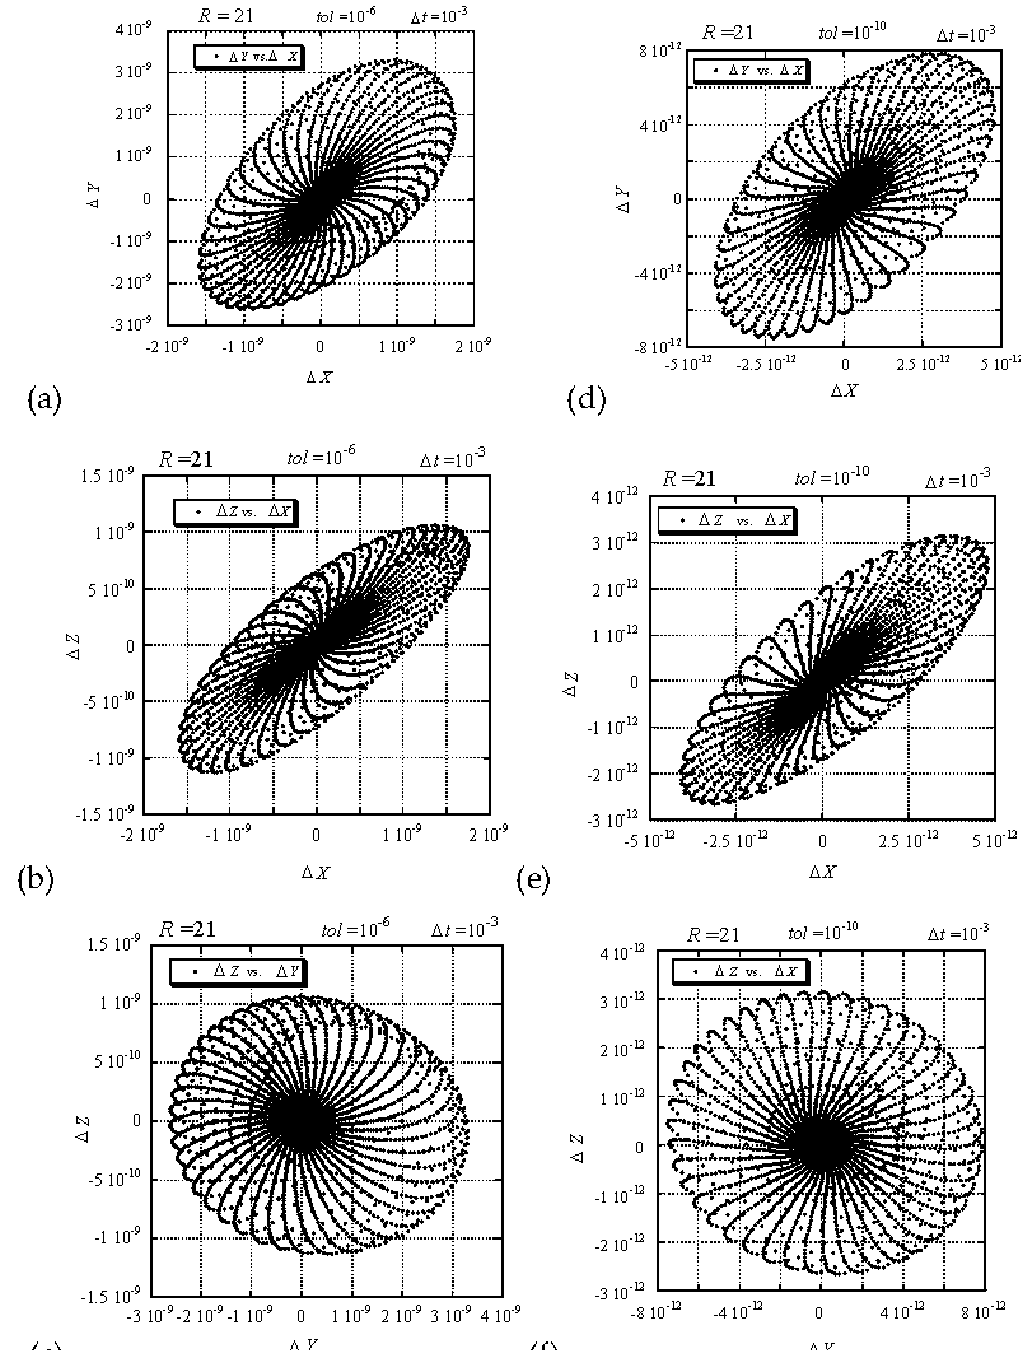
Figure 9. Trajectory of differences between the computational (Adomian decomposition) and numerical (Runge-Kutta) solutions corresponding to ∆ t = 10 − 3 in the computational solution, and R = 21. ( a ) projection of trajectory’s data points on the plane ∆ Z = 0, with tol = 10 − 6 in the numerical solution; ( b ) projection of trajectory’s data points on the plane ∆ Y = 0, with tol = 10 − 6 in the numerical solution; ( c ) projection of trajectory’s data points on the plane ∆ X = 0, with tol = 10 − 6 in the numerical solution; ( d ) projection of trajectory’s data points on the plane ∆ Z = 0, with tol = 10 − 10 in the numerical solution; ( e ) projection of trajectory’s data points on the plane ∆ Y = 0, with tol = 10 − 10 in the numerical solution; ( f ) projection of trajectory’s data points on the plane ∆ X = 0, with tol = 10 − 10 in the numerical solution. (Data points are not connected) [11]. (Reproduced with permission from Peter Vadasz, Shmuel Olek, International Journal of Heat and Mass Transfer; published by Elsevier,